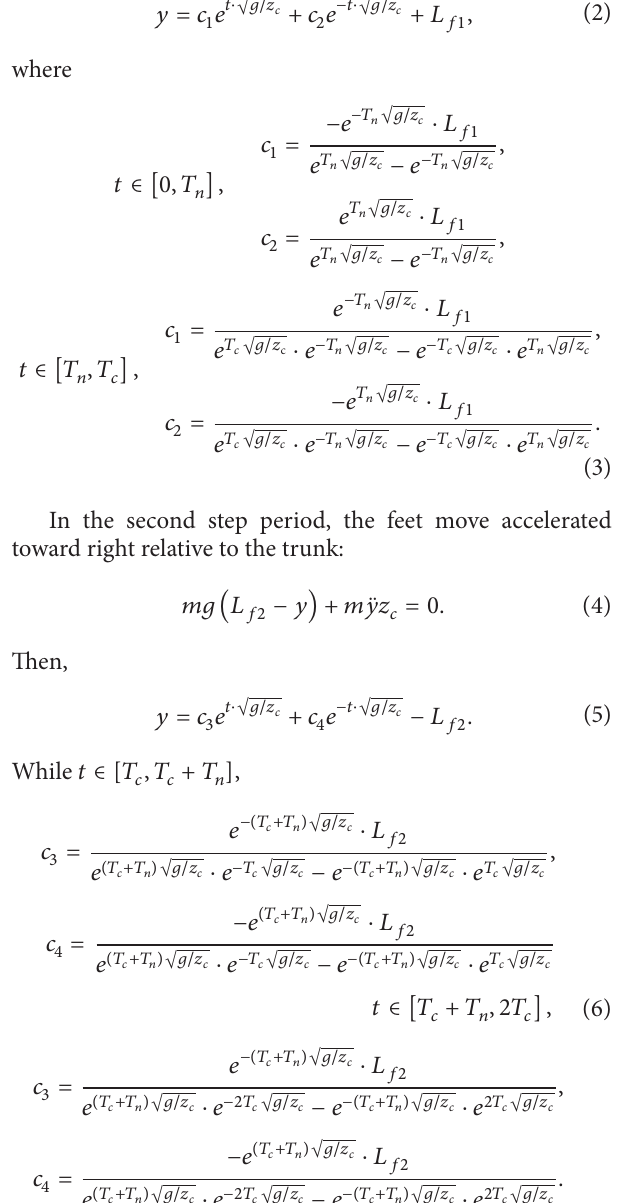
Figure 4: Force analysis in the lateral